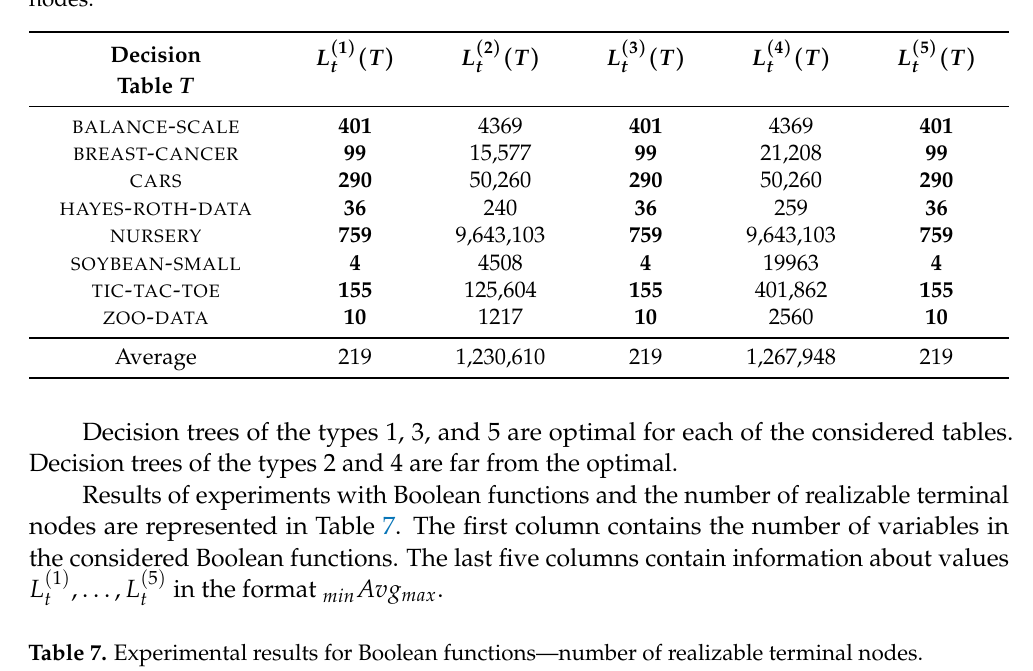
Table 7. Experimental results for Boolean functions—number of realizable terminal nodes. Number of